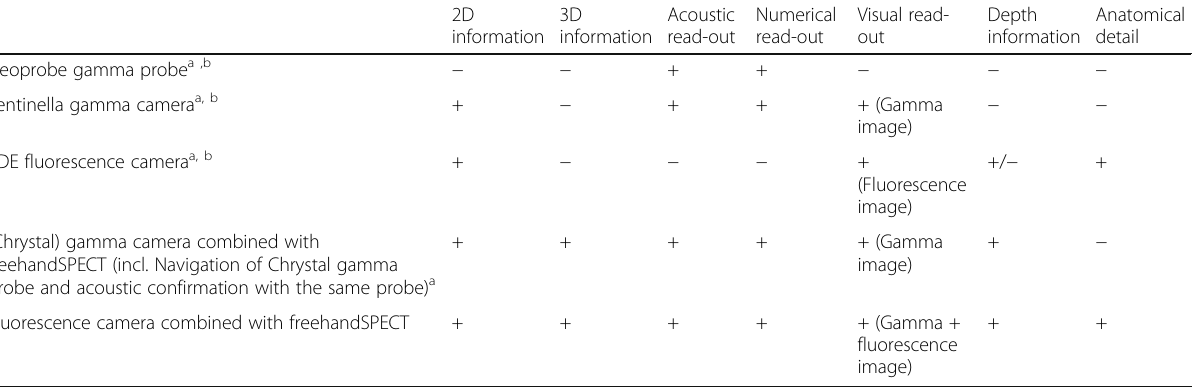
Table 3 Information provided by different intraoperative imaging modalities